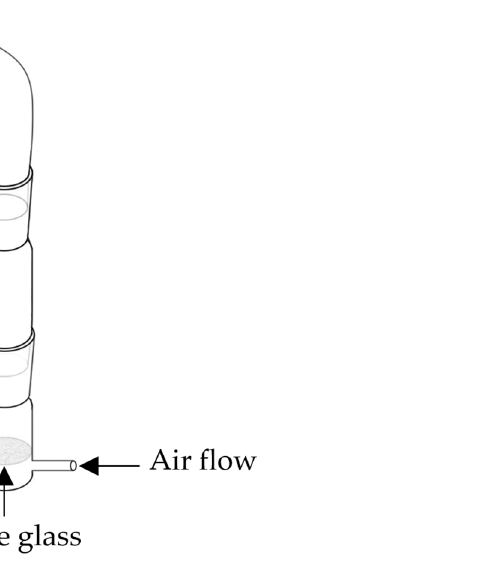
Figure 1. Sketch of the modified Hallimond